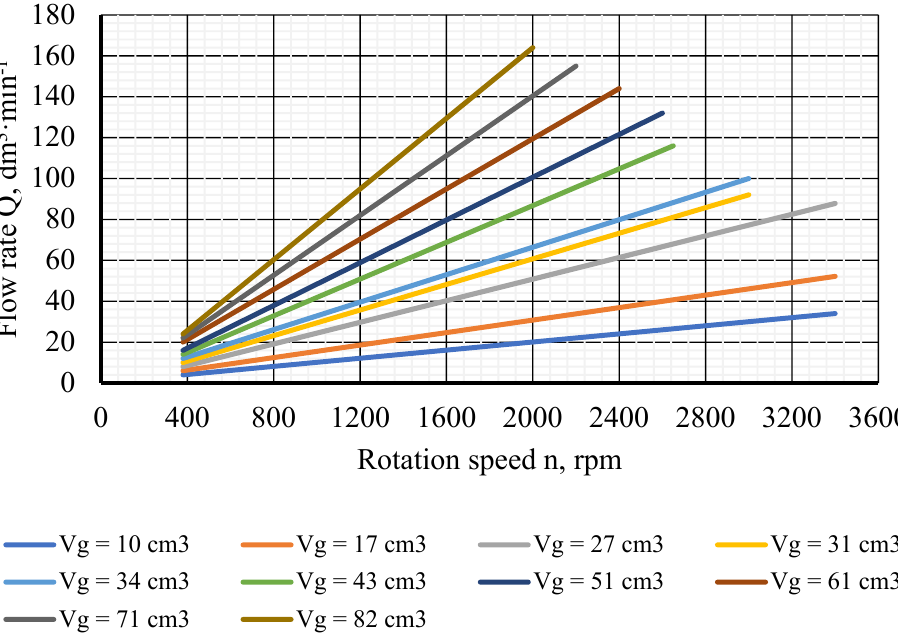
Figure 7 Figure 7. Control system of proposed laboratory equipment in LabVIEW.